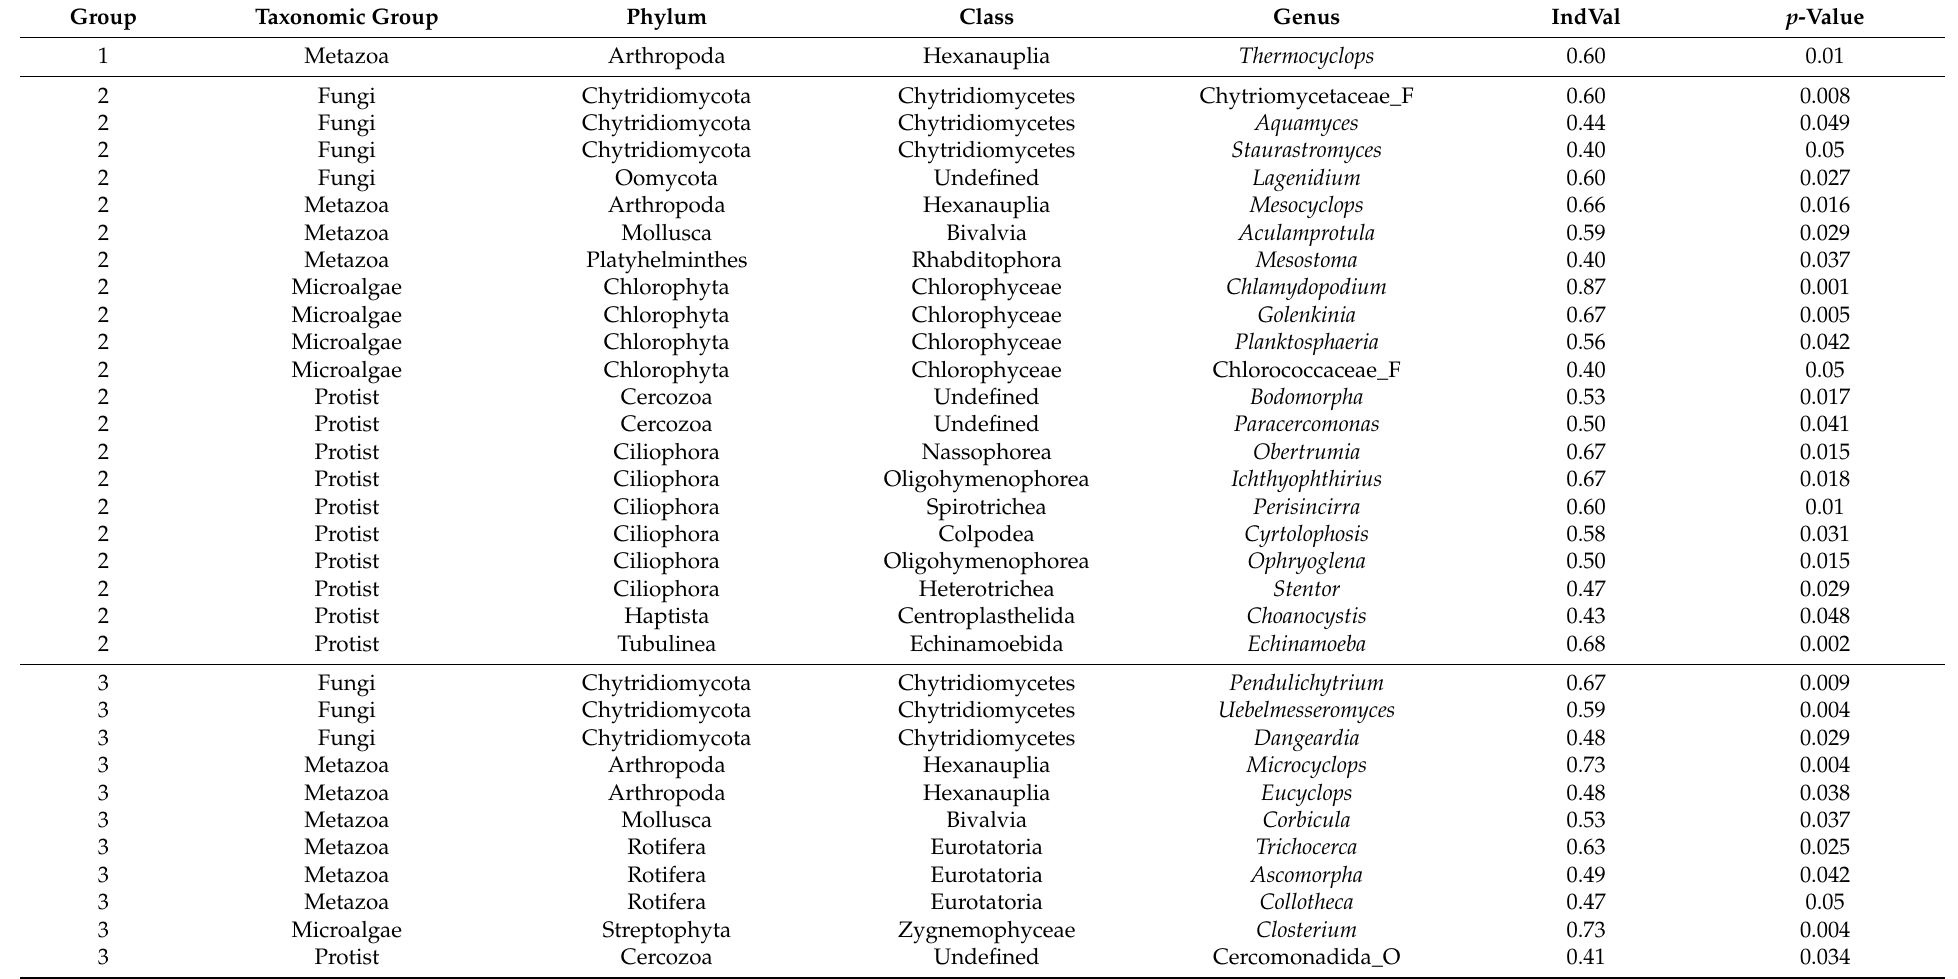
Table 4. Results of the indicator species analysis in four groups (i.e., seasons) at the MG site. Only taxa with significant values are shown (1: spring, 2: summer, 3: autumn, and 4: